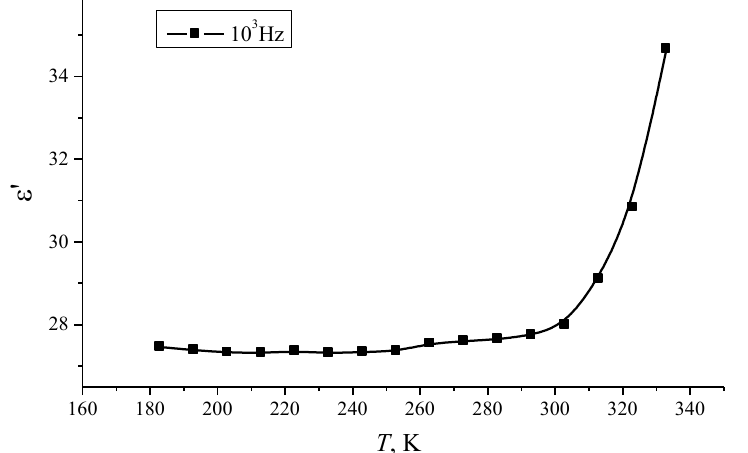
Figure 3. Temperature dependence of the dielectric constant ε ′ of por-Si layers at a frequency of f = 10 3 Hz.